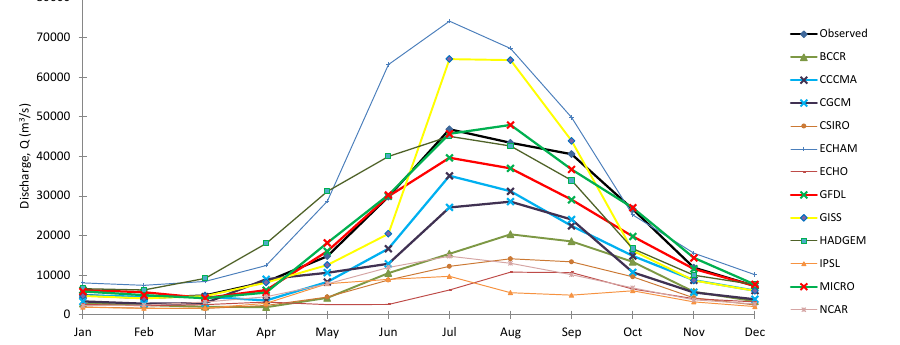
Fig. 2. Comparison of monthly mean discharge as simulated by PCR-GLOBWB with different GCMs as input with that obtained from observed discharge at Bahadurabad